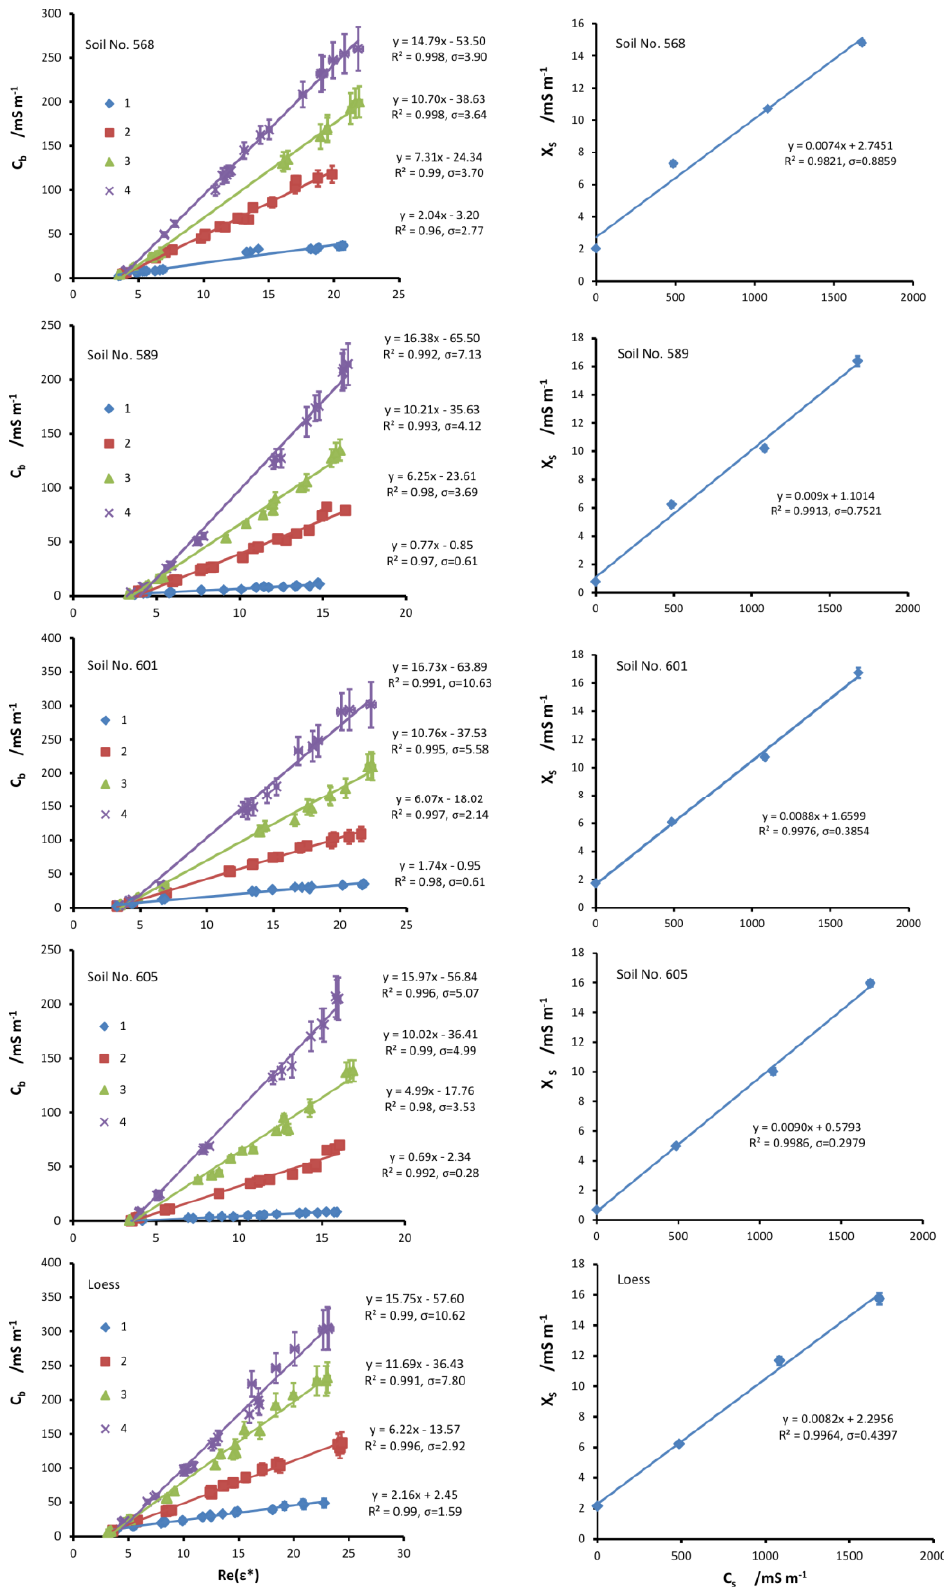
Figure 3. On the left: bulk electrical conductivities of all measured soil samples vs . the real part of the dielectric permittivity. On the right: salinity index (cid:1850) linear (cid:1829) vs. (cid:2013) (cid:4593) relation, with respect to the conductivity of the moistening solutions (cid:1829) (cid:3029) Regression equations, (cid:1844) (cid:2870) and standard errors of regressions are given on the